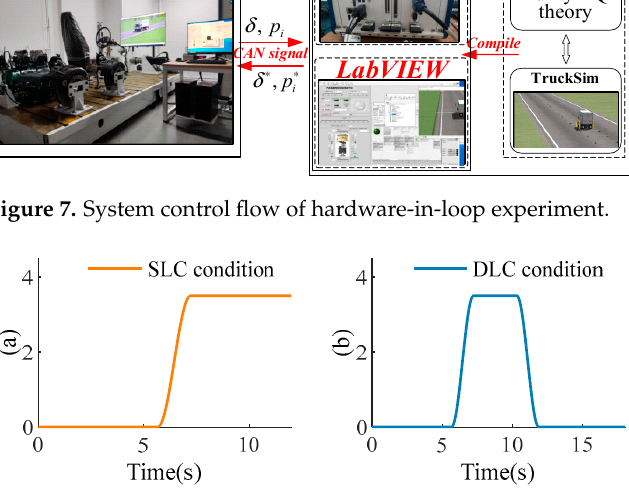
Figure 7. System control flow of hardware-in-loop experiment.